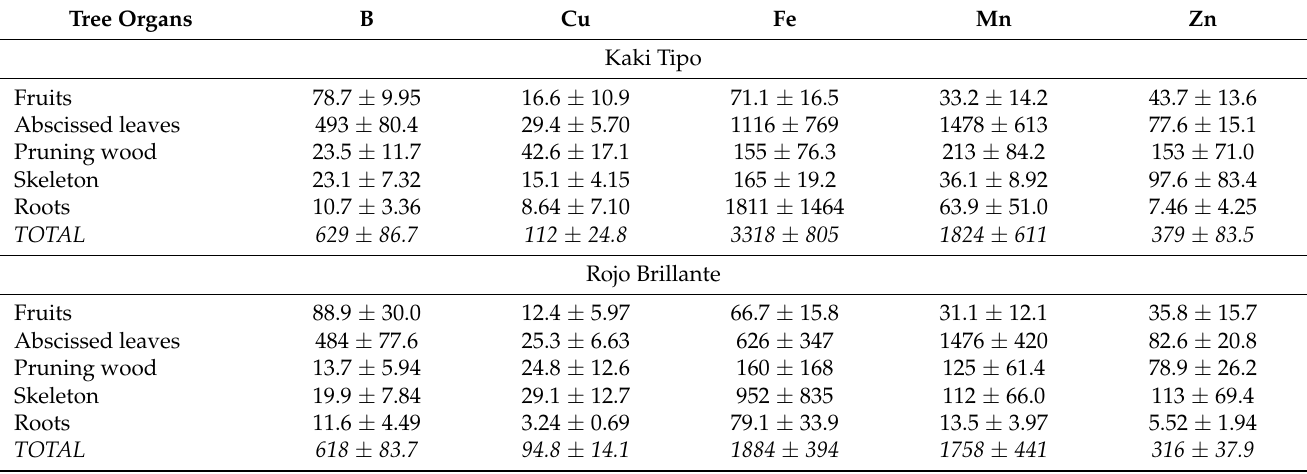
Table 4. Annual micronutrient content (mg tree − 1 year − 1 ) in tree organs of mature persimmon of cultivar Kaki Tipo and Rojo Brillante (means ± SD; n = 20 for new growth and 4 for perennial